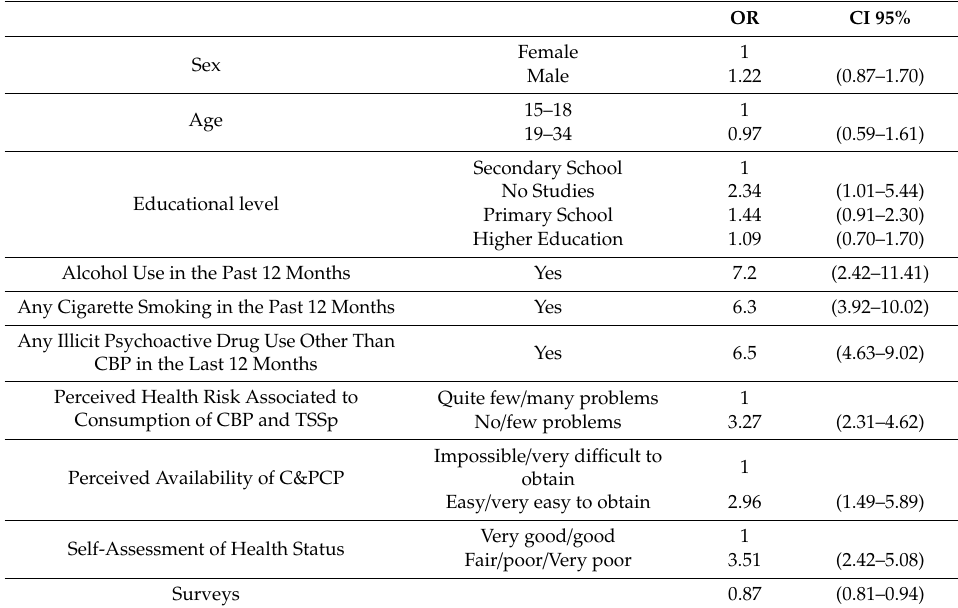
Table 2. Multivariable logistic regression of factors associated with co-use of cannabis and other cannabis-based products and misuse of tranquilizers, sedatives, and sleeping pills in young adults of both sexes, aged 15 to 34 years in Spain. EDADES survey